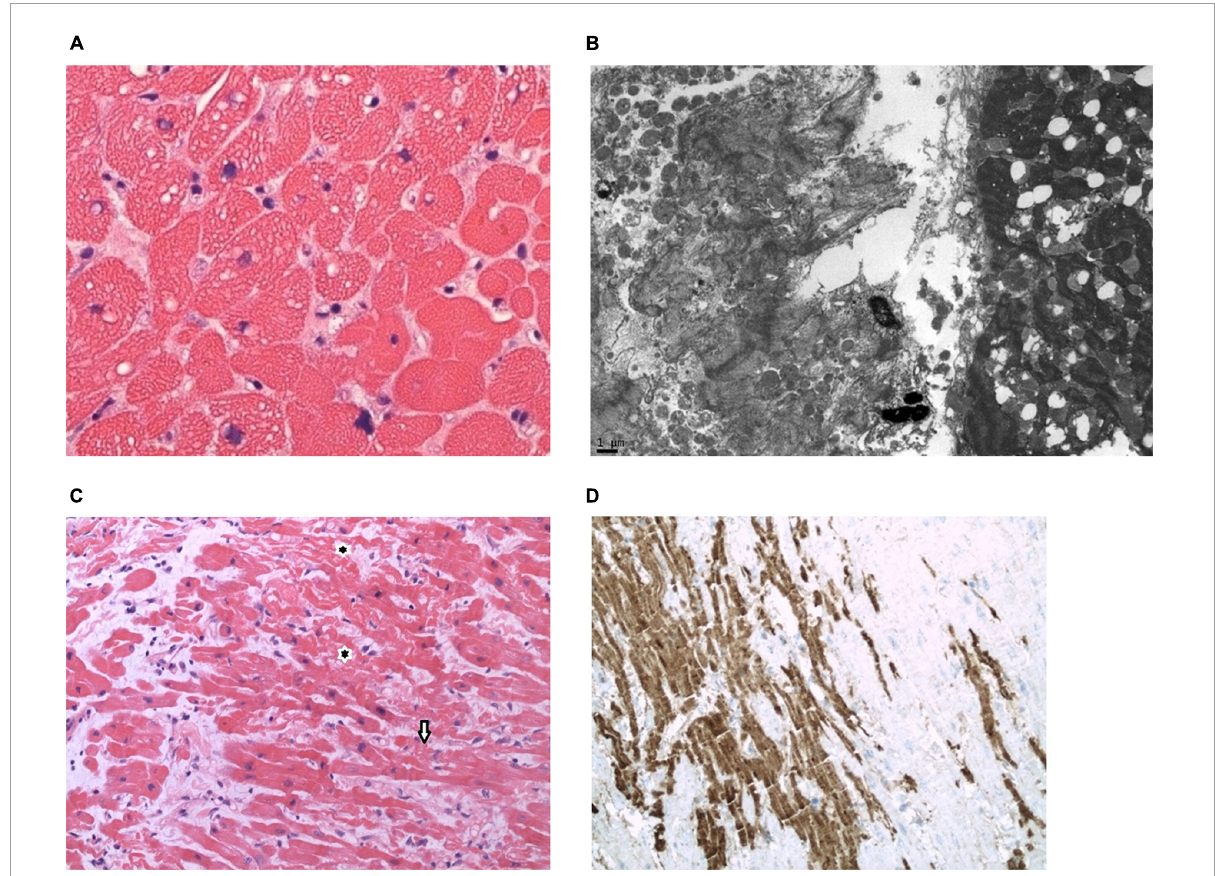
FIGURE3 Pathological observations. (A,B) . Endomyocardial biopsy (EMB) on post-orthotopic heart transplant (OHT) Day 2 from a 55-year-old man with non-ischemic cardiomyopathy associated with cardiac sarcoidosis who manifested clinical features of early graft dysfunction. Triglyceride droplets in cardiomyocytes (CMC) are evidence of CMC injury. EMB confirmed the lipidosis and focal contraction band necrosis of CMC. Patient expired on post-OHT Day 28. (C,D) . EMB on post-OHT Day 5 from a 71-year-old man with non-ischemic cardiomyopathy who manifest clinical features of early graft dysfunction. EMB shows features of CMC injury with contraction bands (arrows) and marked C4d uptake into the damaged CMC. Patient expired on post-OHT day 35. [ (A) , hematoxylin and eosin stain, high magnification; (B) , electron micrograph; (C) , hematoxylin and eosin stain, medium magnification; (D) , C4d immunostain, medium